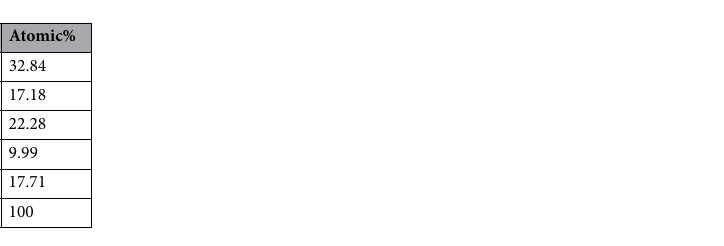
Table 1. A chart of the elemental composition of the nanohybrid In 2 O 3 /MoS 2 /Fe 3 O 4 from EDAX spectrum.